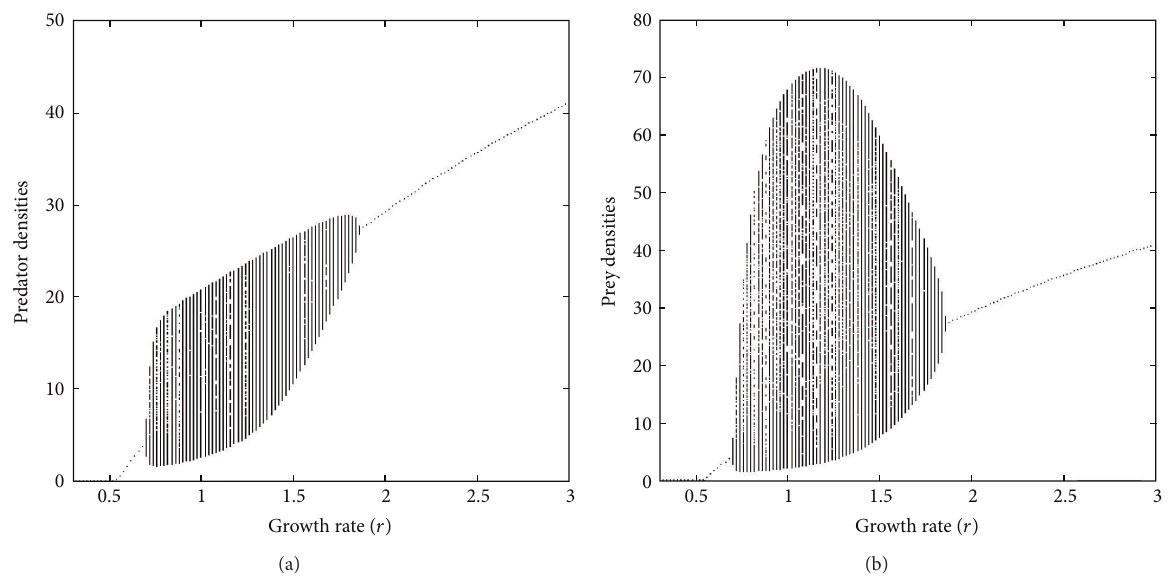
Figure 7: Bifurcation diagrams of predator and prey densities in model (24) with the initial conditions 𝑥 0 = 30 , 𝑦 0 = 20 and the parameter values 𝛼 = 0.03 , 𝛽 = 0.1 , 𝐾 = 100 , and 𝑢 2 = 18